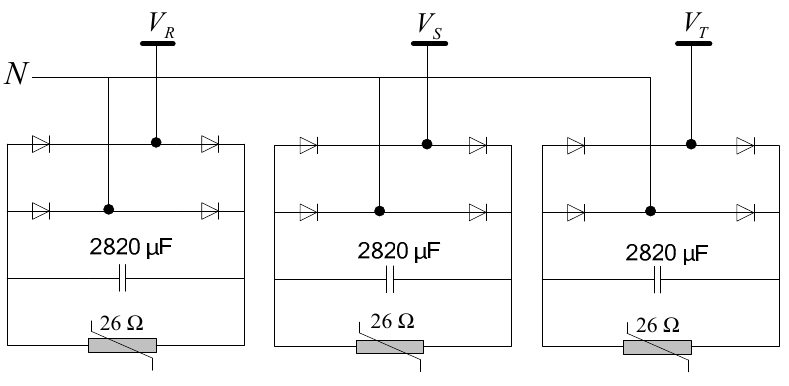
Figure 25. Three-phase, balanced, non-linear load.